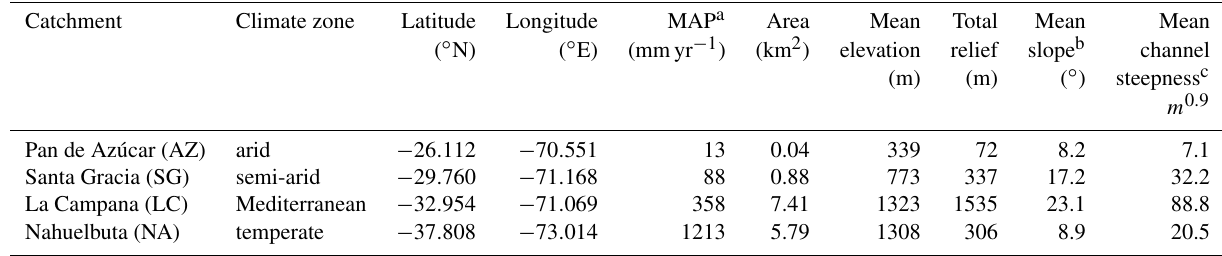
Table 1. Sample location coordinates and catchment attributes of the research areas located in the Chilean Coastal Cordillera. Catchment Climate zone Latitude Longitude MAP a Area Mean Total Mean Mean ( ◦ N) (mmyr − 1 ) (km 2 ) elevation relief slope b steepness c